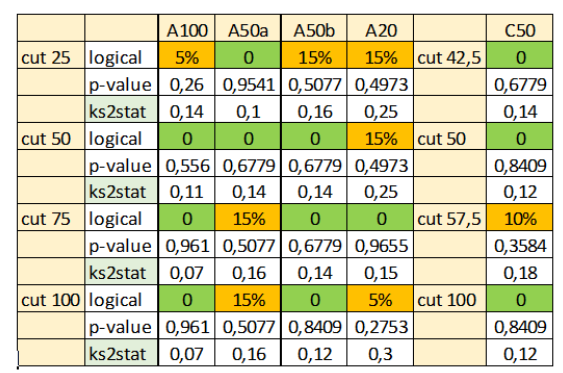
Tab. 1. Table with results of K-S testing. Logical value 0 indicates acceptance of hypothesis that both datasets are from the same distribution. In other cases we depict the significance level, on which the hypothesis can be refused.